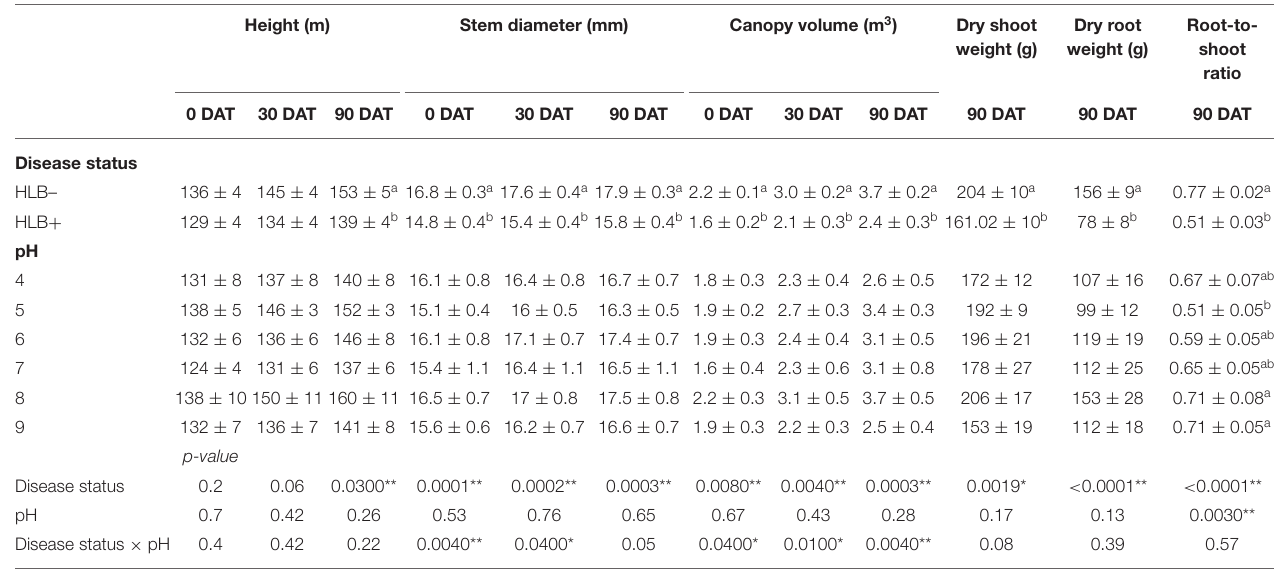
TABLE 4 | Plant size and biomass of “Ray Ruby” grapefruit ( C. paradisi ) on sour orange ( C. aurantium ) rootstock exposed to different HLB disease statuses [HLB-free or healthy (negative, HLB–) and HLB-affected (positive, HLB + )] under an increasing range of substrate pHs (4–9) at 0, 30, and 90 DAT. Height (m) Stem diameter (mm) Canopy volume (m 3 ) Dry shoot